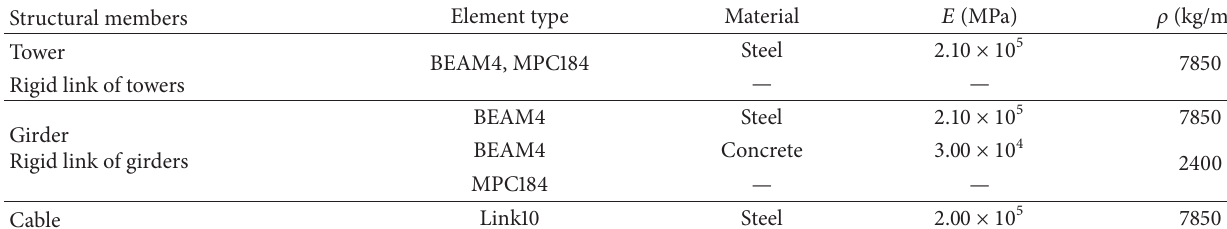
(b) Cross section of concrete girder Figure 3: Main girder sections [21]. Table 1: Properties of structural